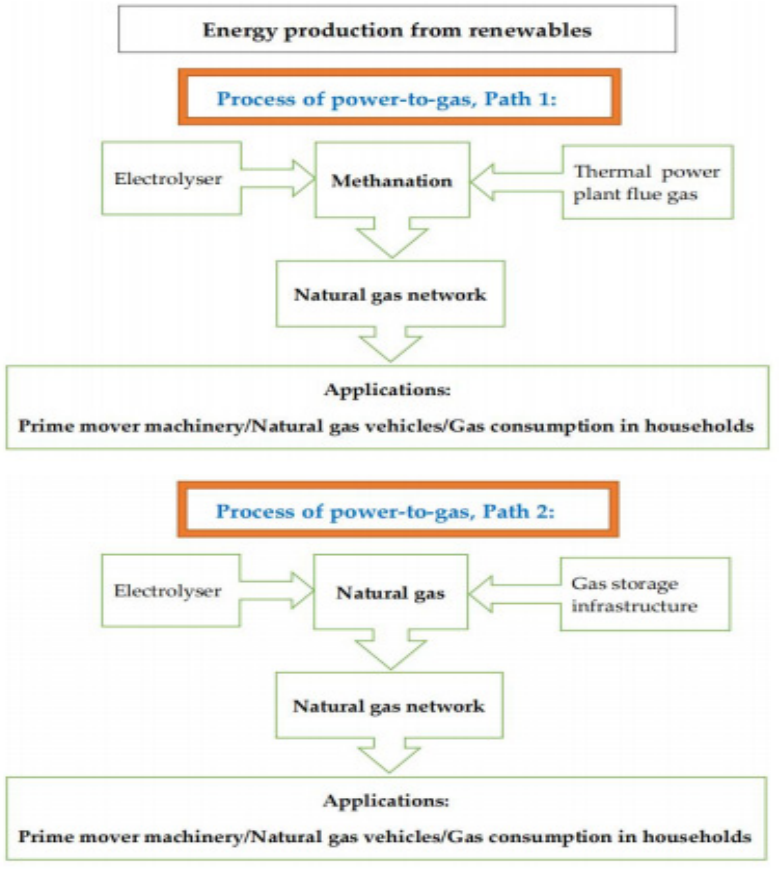
Figure 1. Procedural profile of the P2G process. Source: Z. Liu et al. 2021.